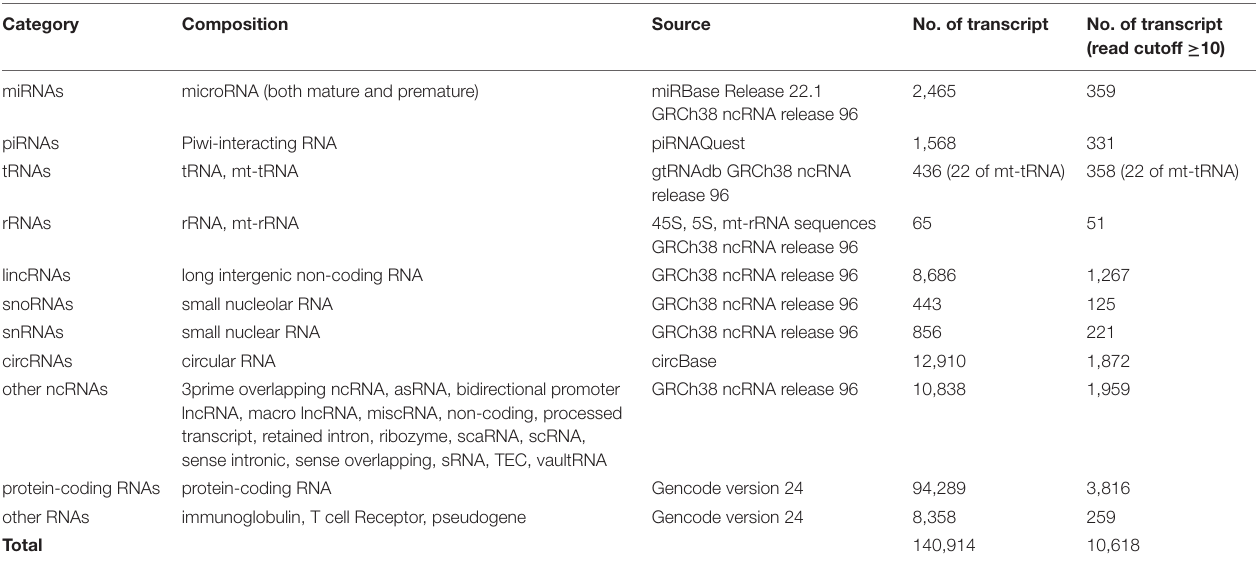
FIGURE 2 | Distribution pattern of exRNA size and read count in different plasma fractions. (A) Average insert size of each fraction (ns-not significant, p > 0.05, one-way ANOVA). (B) Mappable rate of each fraction (* p < 0.05, ** p < 0.01, *** p < 0.001, one-way ANOVA). (C) Read count of average length of inserts. (D) Proportion of size distribution. Solid line represents each fraction. The numbers 1–4 represent Precipitate 1, Precipitate 2, EV Precipitate, and the leftover, respectively. TABLE 3 | RNA categories and sources of RNA references for